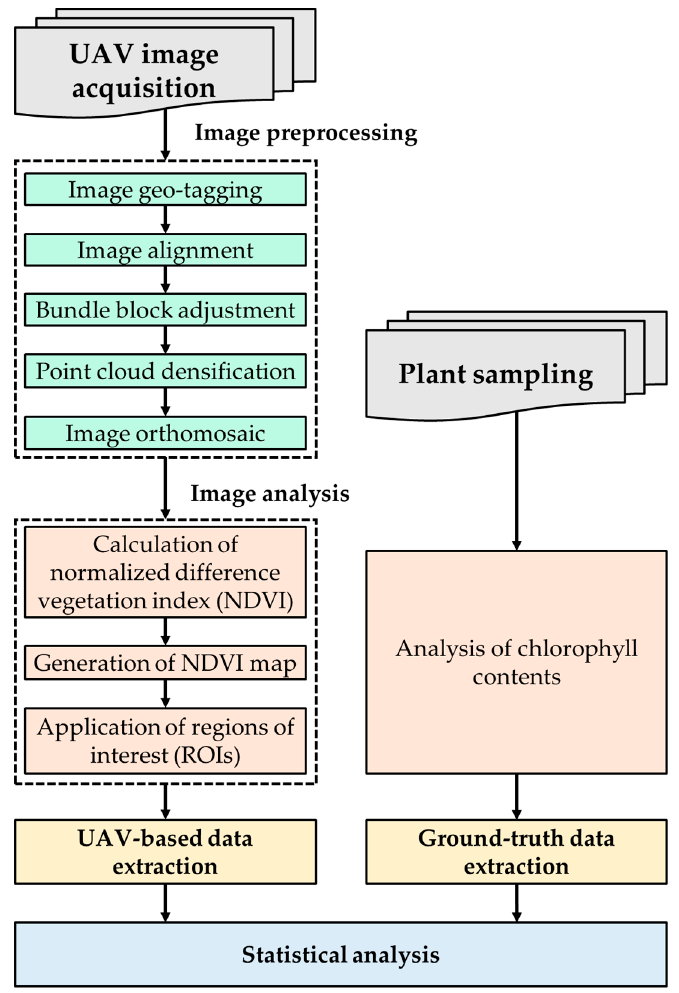
Figure 3. Flow chart of the image preprocessing and analysis steps.